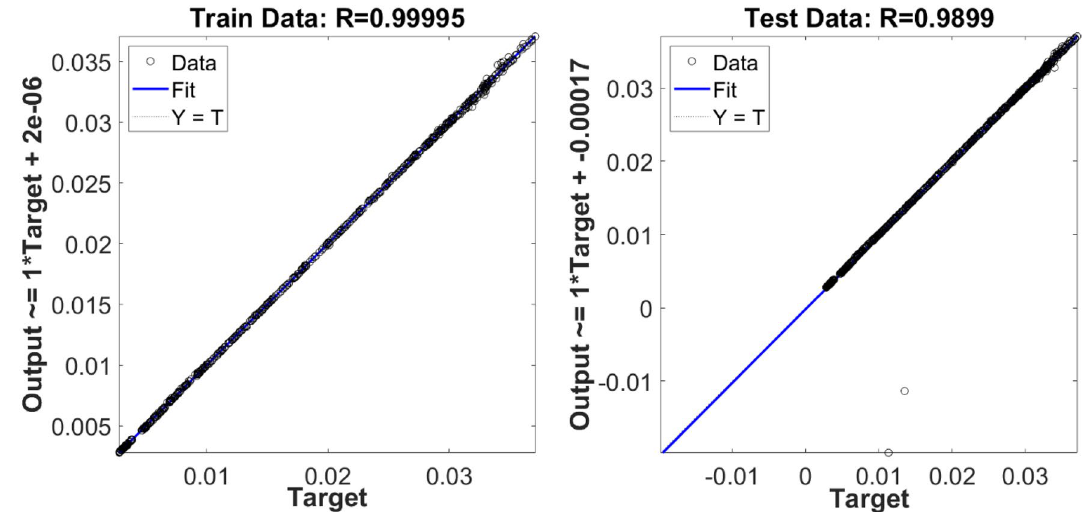
Figure 7. Training and testing accuracy results.